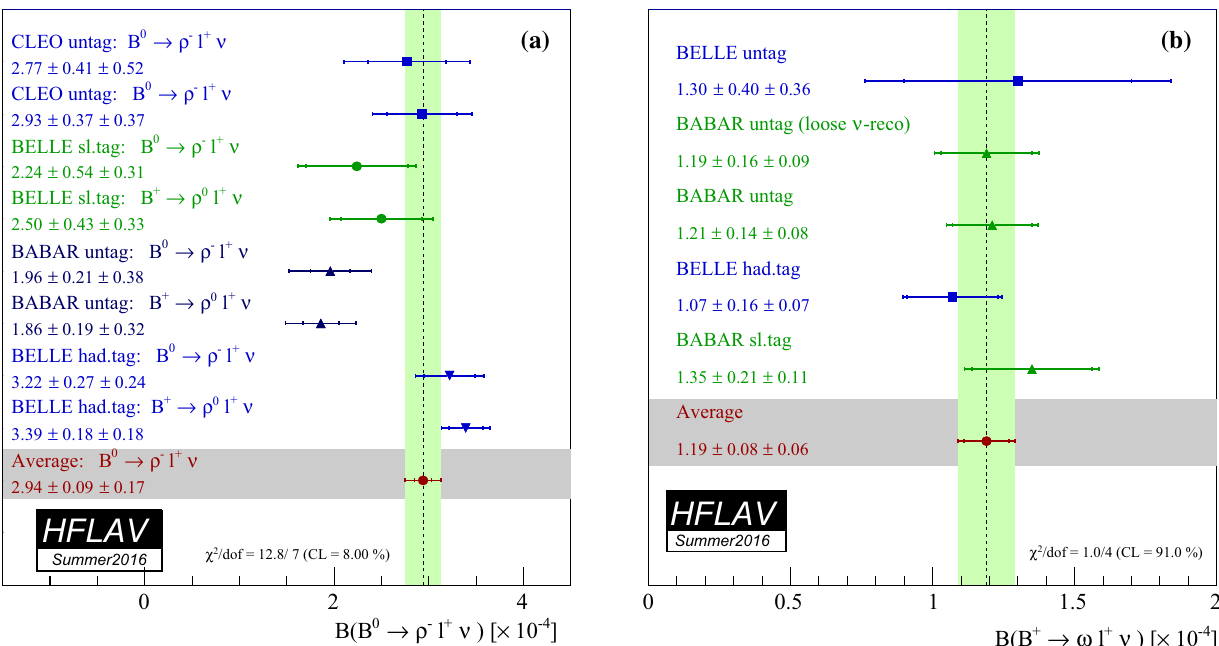
Fig. 61 a Summary of exclusive determinations of B ( B 0 → ρ(cid:12) + ν) and their average. Measurements of B + → ρ 0 (cid:12) + ν branching fractions have been multiplied by 2 τ B 0 /τ B + in accordance with isospin symmetry. b Summary of exclusive determinations of B + → ω(cid:12) + ν and their average